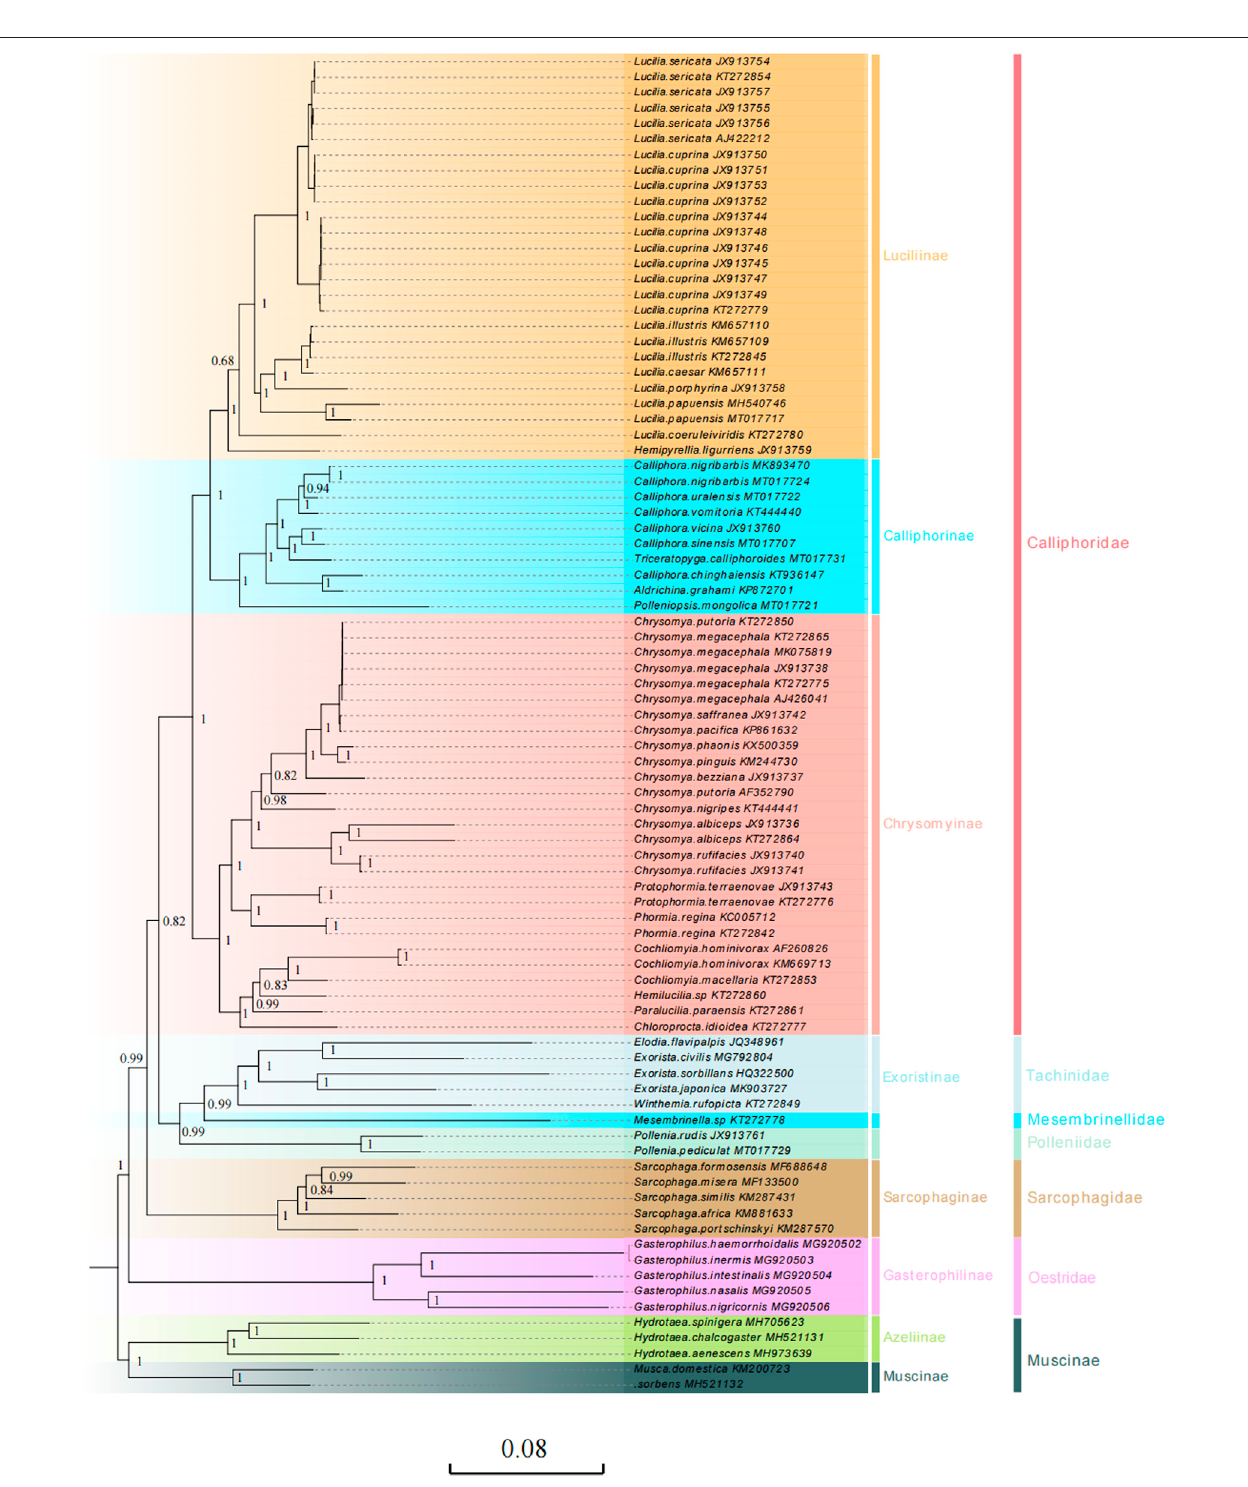
FIGURE 5 | Phylogenetic analyses of 34 calliphorid species (including 63 mitogenomic sequences) within the larger context of the other 18 Oestroidea species were constructed based on the sequences of 13 PCGs (excluding the termination codons) and two rRNAs using Bayesian methods (BI). The fi ve Muscidae species (Insecta:Diptera:Muscoidea)servedastheoutgroup.NumbersonbranchesareBayesianposteriorprobabilities(PP).Differentcolorsrepresentdifferentsubfamiliesthe species belong to. The two column taxonomic groups on the right side represent subfamilies and family according to the traditional morphological classi fi cation, respectively.